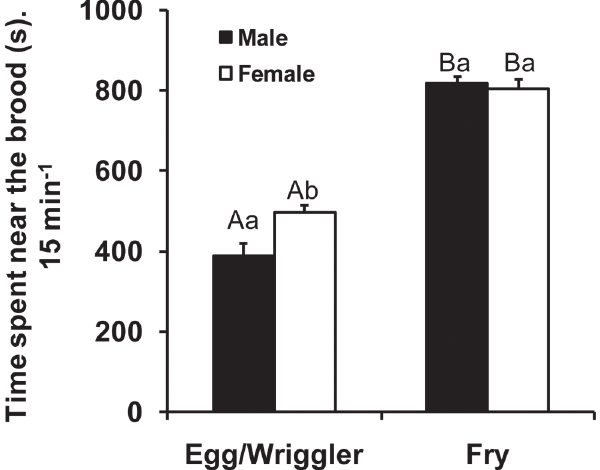
Fig. 4. Mean frequency (± SE) of agonistic acts given by male and female in the pre-spawning (n = 11), egg/wriggler (n = 11) and free-swimming fry (n = 12) phases. NS is non significant values (Two-way ANOVA followed by Tukey post hoc